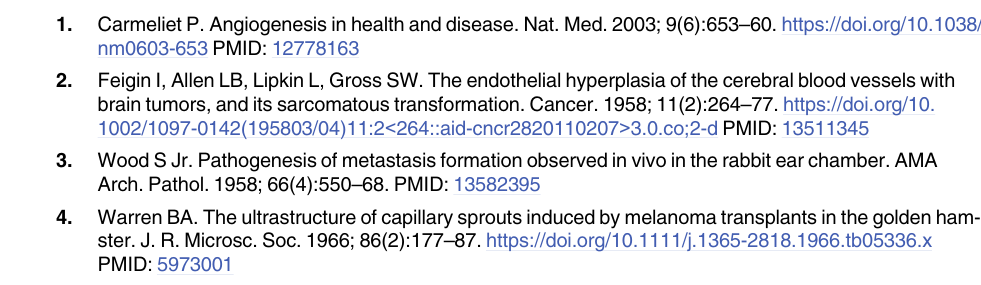
three regions for the Foxo1 and C ) Prkci mutants and the respective controls at P5. In (B) and (C), the red and blue bars represent the results of mutant and control cases, respectively. (TIF) S1 Table. The ratio of the averaged flow rates in the inner plexus and angiogenic front regions before and after grid refinement.